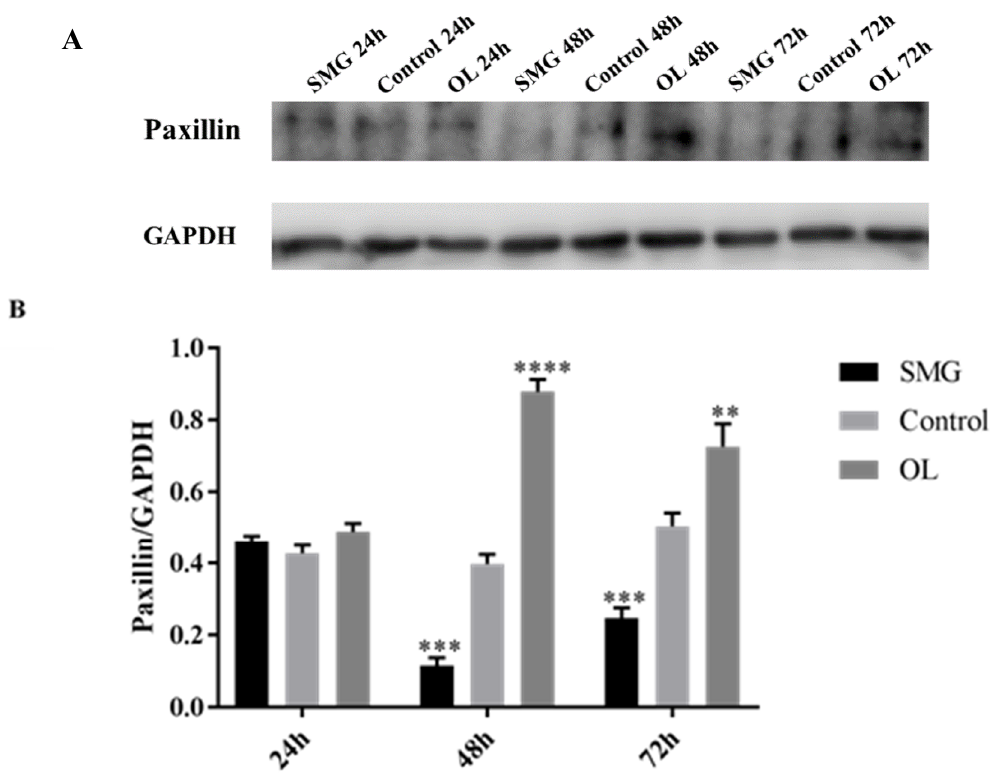
Figure 11. Western blot analysis of cells paxillin in MCF-7 cells after mechanical changes. ( A ) Results for Western blots. ( B ) Reflective densitometry of Western blots. Significant di ff erence; ** p < 0.01, *** p < 0.001 and **** p < 0.0001, extremely significant.